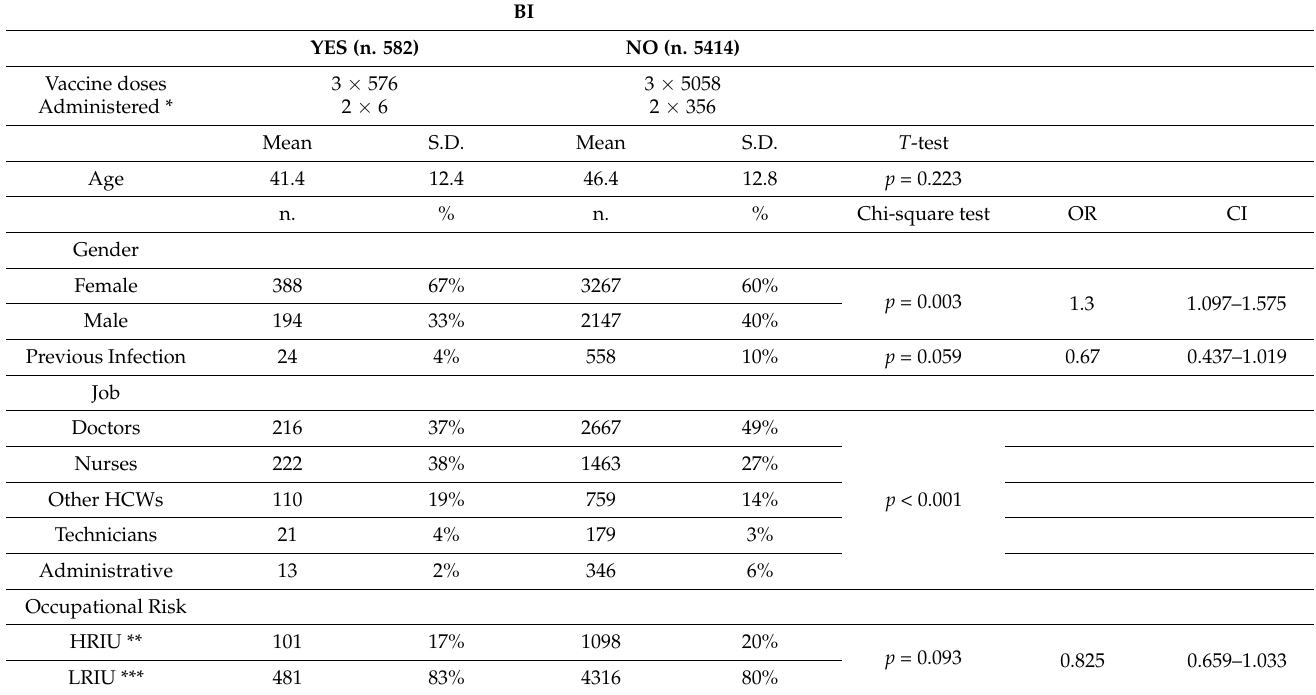
Table 2. Comparison between BI group and non-BI